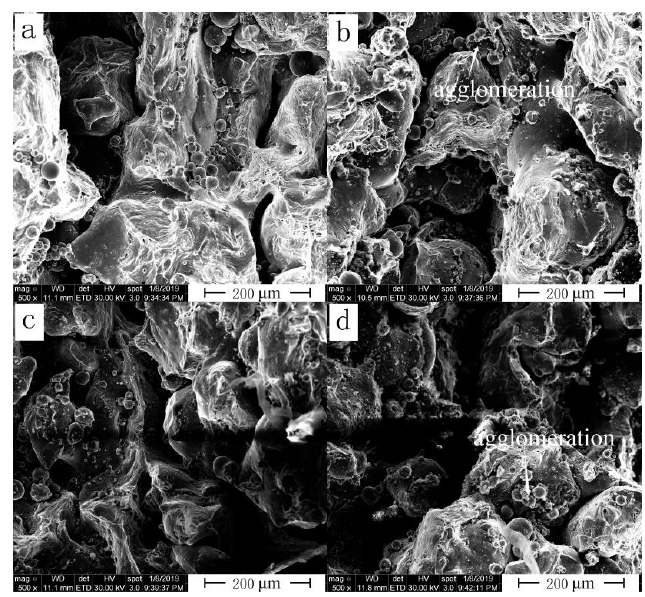
Figure 11. Fracture morphology of the SLM alloy formed at different scanning speeds: ( a ) 700 mm/s, ( b ) 800 mm / s, ( c ) 900 mm / s and ( d ) 1000 mm / s.